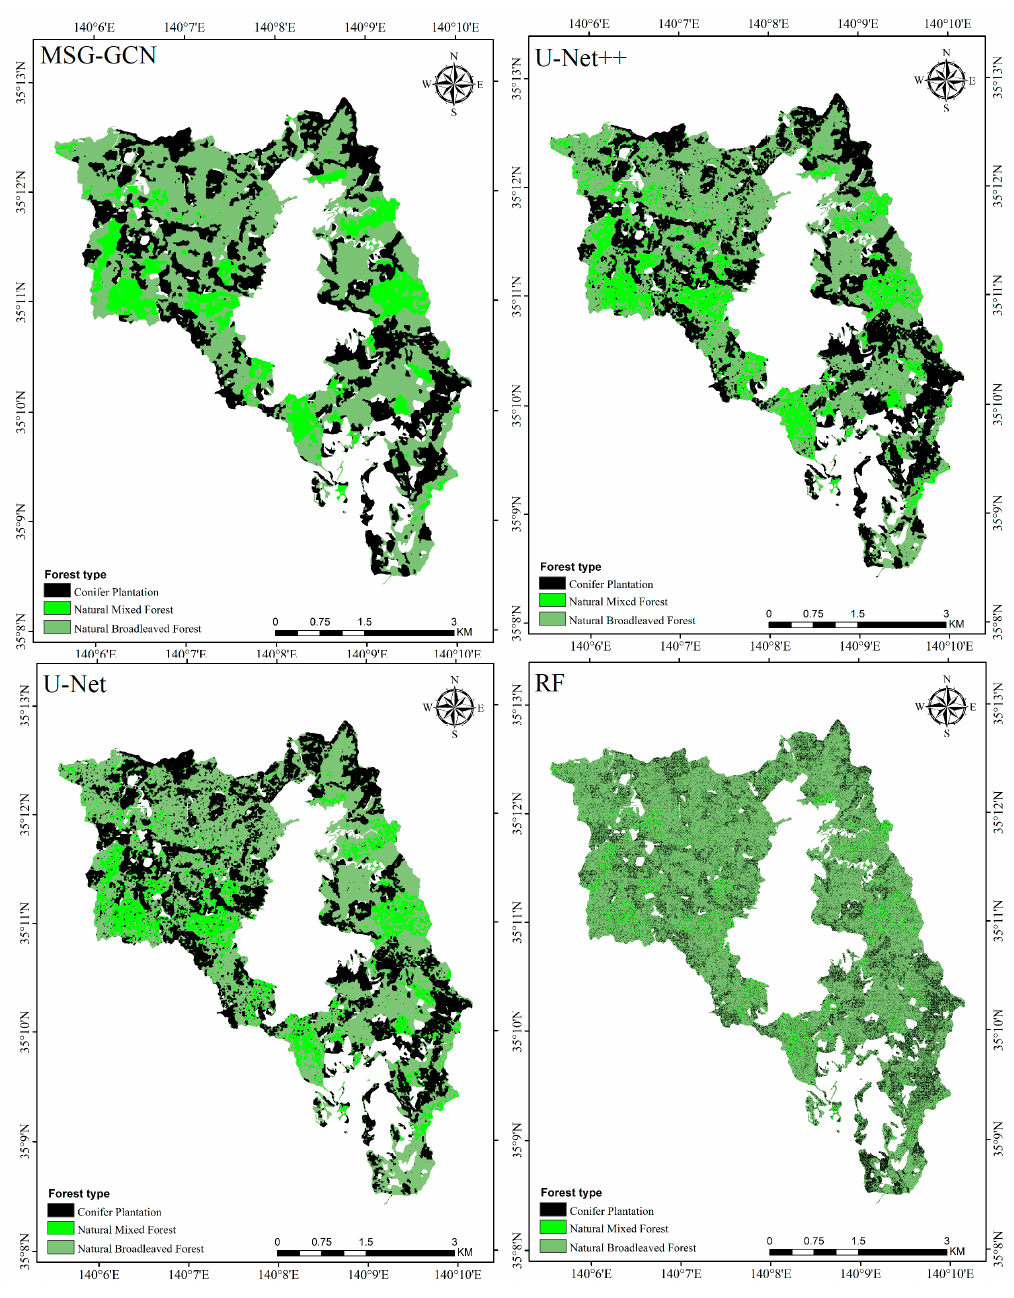
Figure 7. Visualisation of the entire study area.